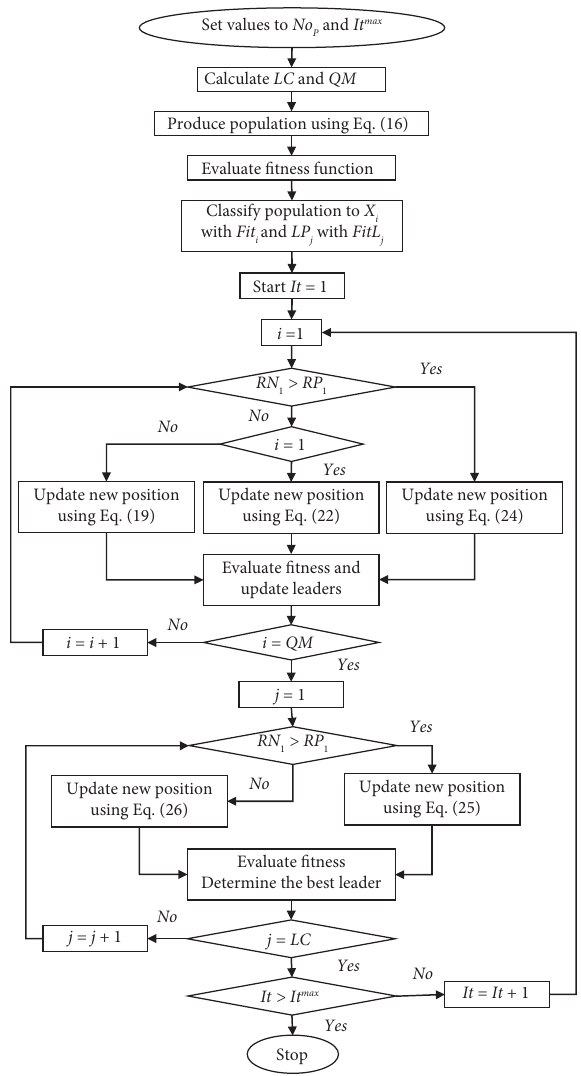
Figure 1: Flowchart of applying COOA for an optimization